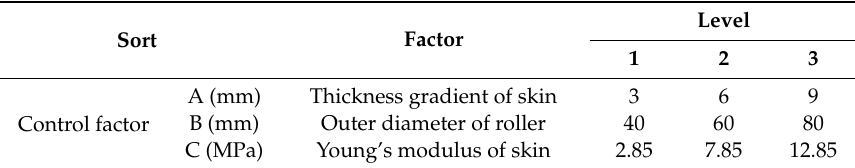
Table 2. Design factors and initial levels of each